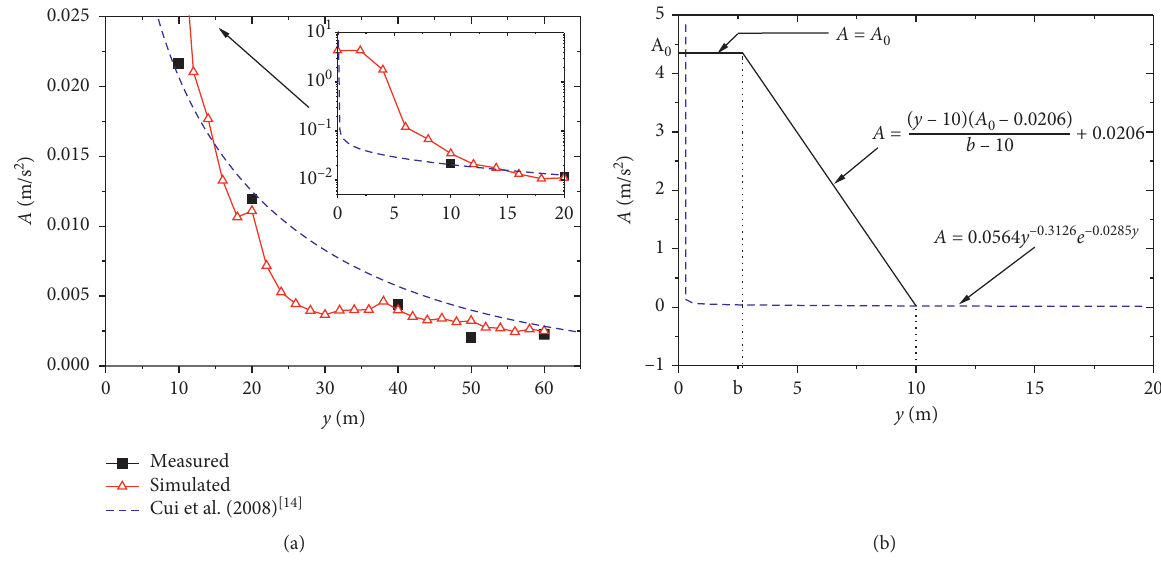
Figure 10: Attenuation of ground vibration intensity: (a) attenuation feature; (b) attenuation relationship.